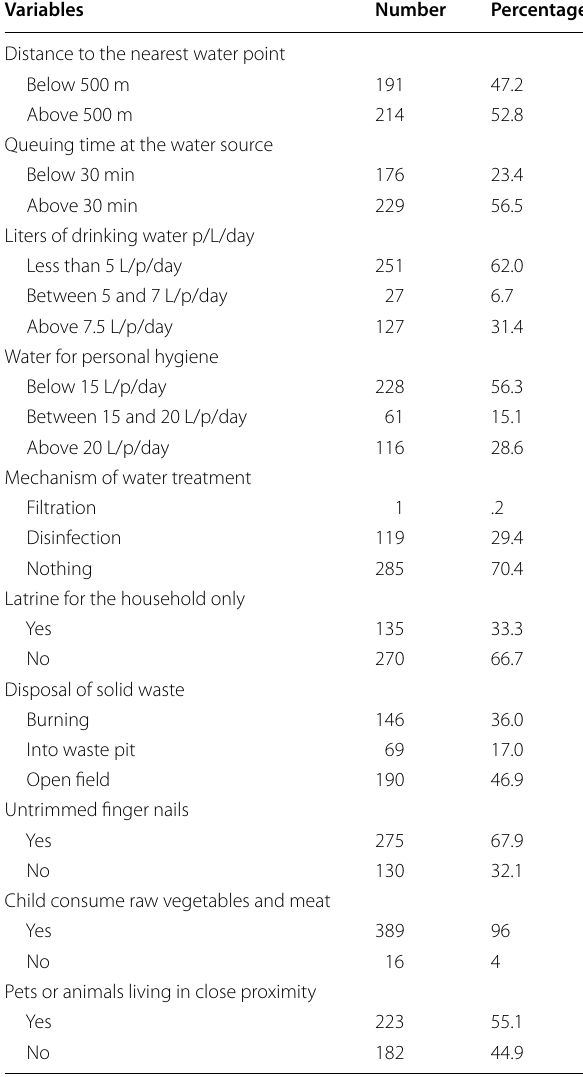
Table 5 Frequency of selected determinants among the study participants, southern Ethiopia,